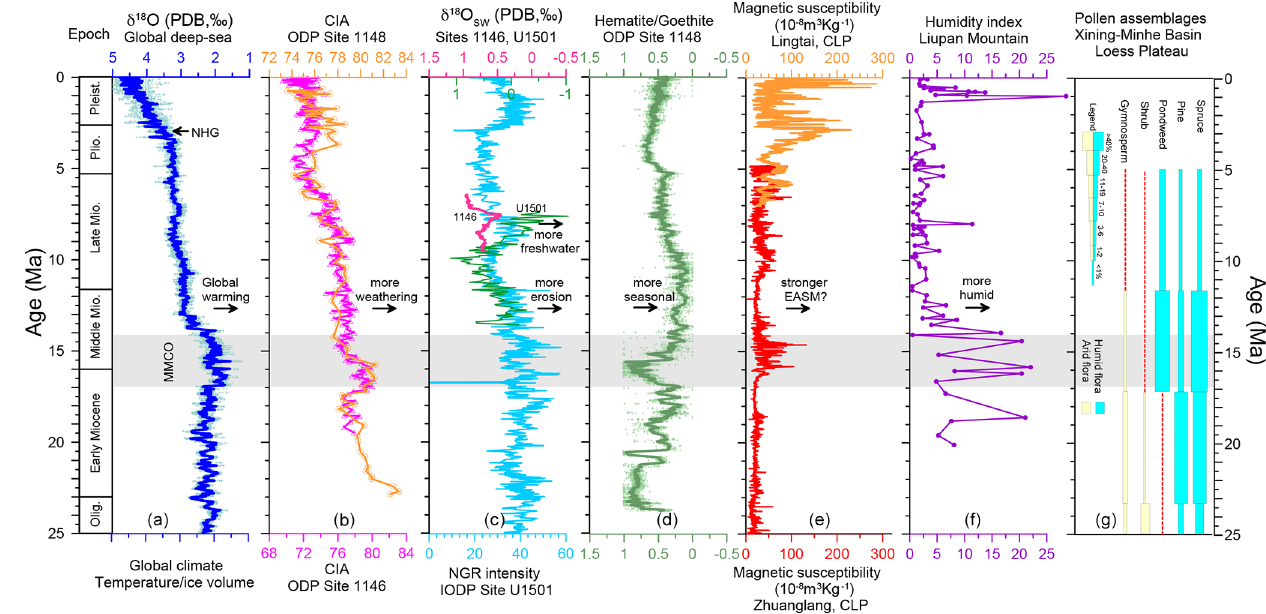
Figure 6. Proxies from land and sea showing the evolution of global climate and East Asian summer monsoon since 25Ma. (a) Global deep-sea δ 18 O (Westerhold et al., 2020); (b) chemical index of alteration at ODP Site 1146 (Wan et al., 2010) and 1148 (Wei et al., 2006) in the northern South China Sea; (c) seawater δ 18 O at ODP Site 1146 (Steinke et al., 2010) and IODP Site U1501 (Yang et al., 2021), as well as NGR intensity at Site U1501 (Jian et al., 2018); (d) hematite/goethite ratio at ODP Site 1148 (Clift et al., 2008); (e) magnetic susceptibility of loess–paleosol sequences (Ding et al., 1999; Qiang et al., 2011); (f) pollen-based humidity index from Liupan Mountain (Jiang and Ding, 2008); (g) pollen assemblage evolution at Xining Basin (Sun and Wang, 2005). All drilling sites are located in the northern South China Sea on the continental